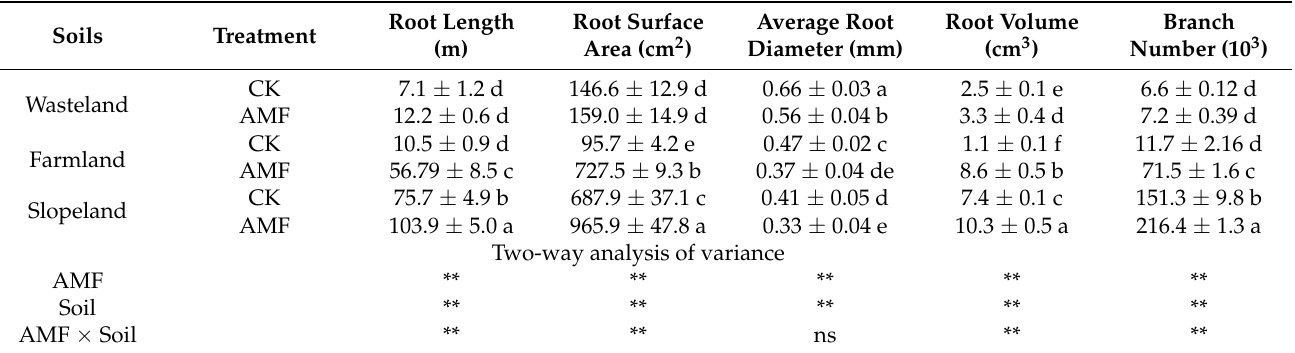
Table 4. Effects of AMF on the morphology of maize roots. The different lowercase letters indicate significant differences among treatments; “ns” and “**” mean no significance and p < 0.01 according to two-way analysis of variance,